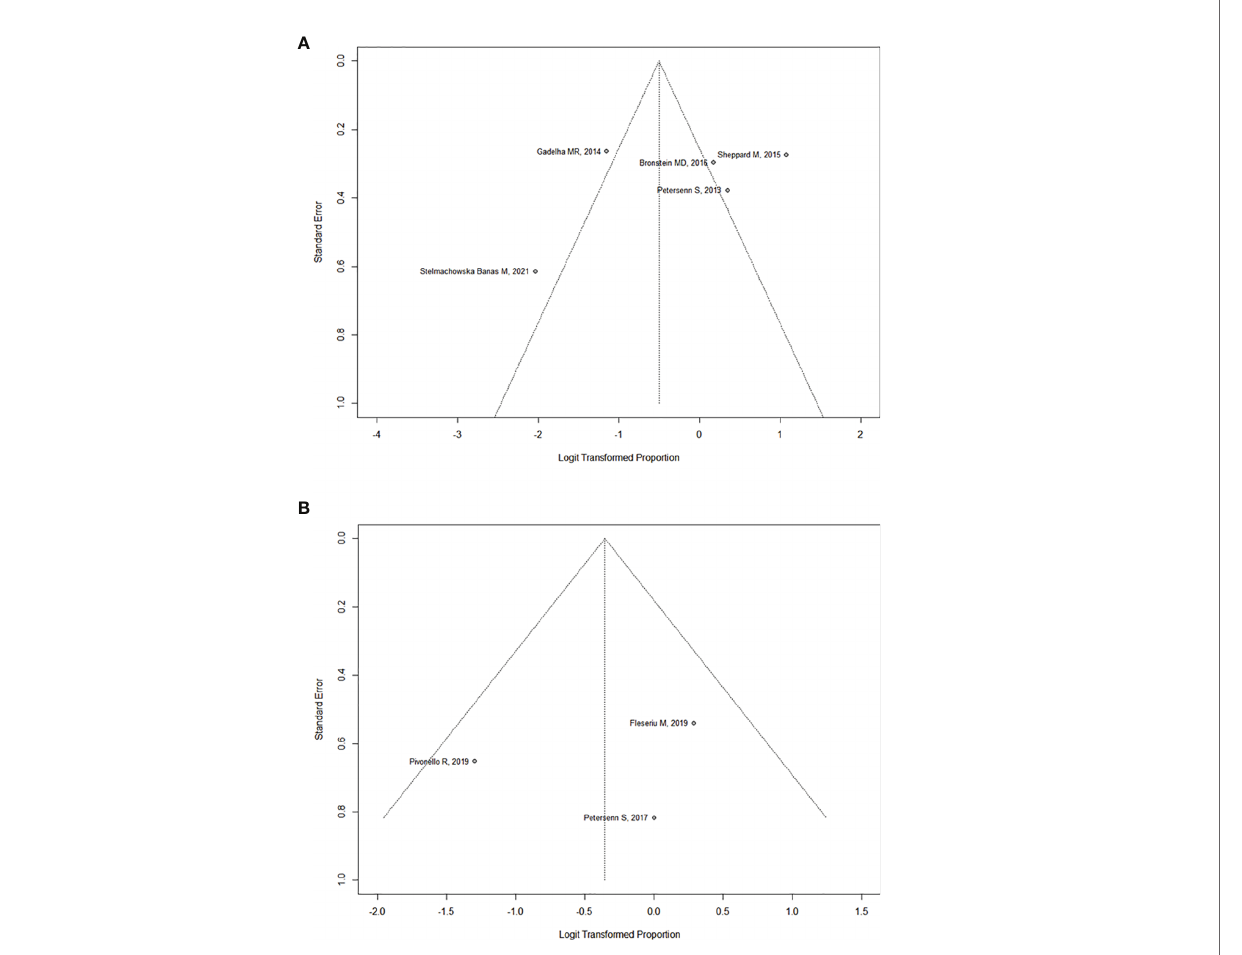
FIGURE 6 | (A) Funnel plot assessing publication bias for Acromegaly. (B) Funnel plot assessing publication bias for Cushing ’ s